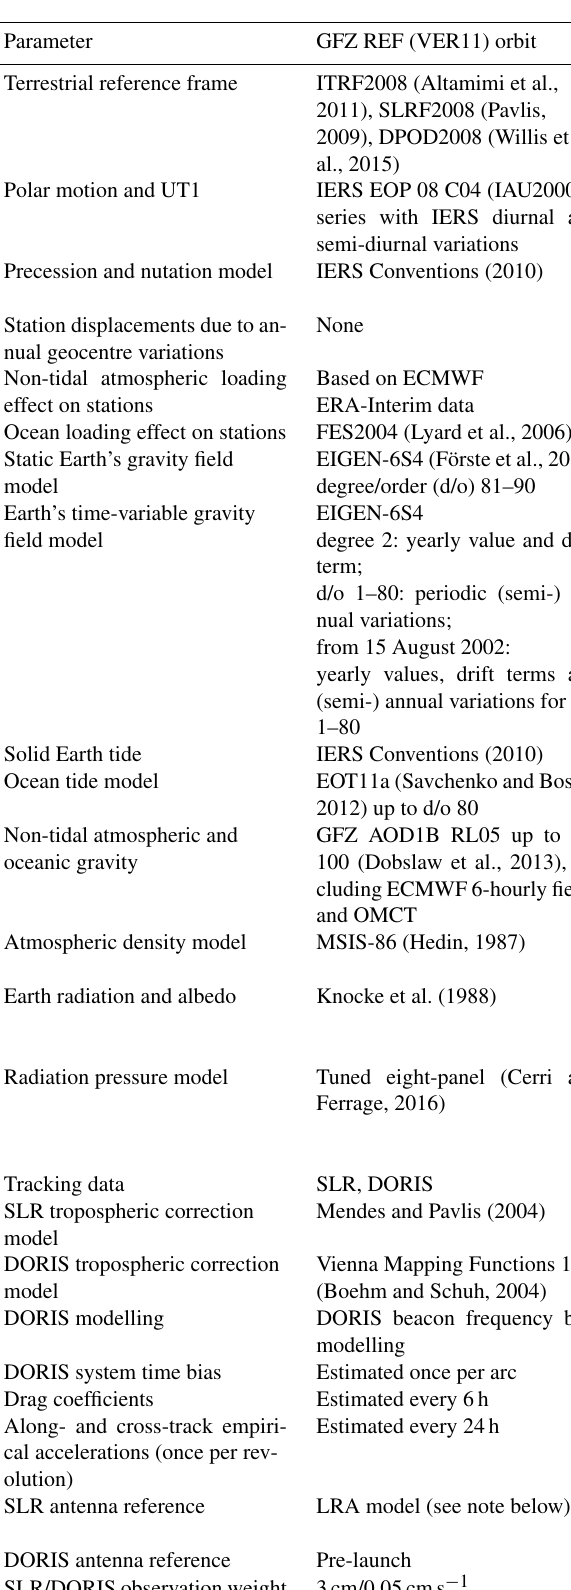
Table 1. The main models used for calculation of GFZ VER11, GSFC std1504, and GRGS